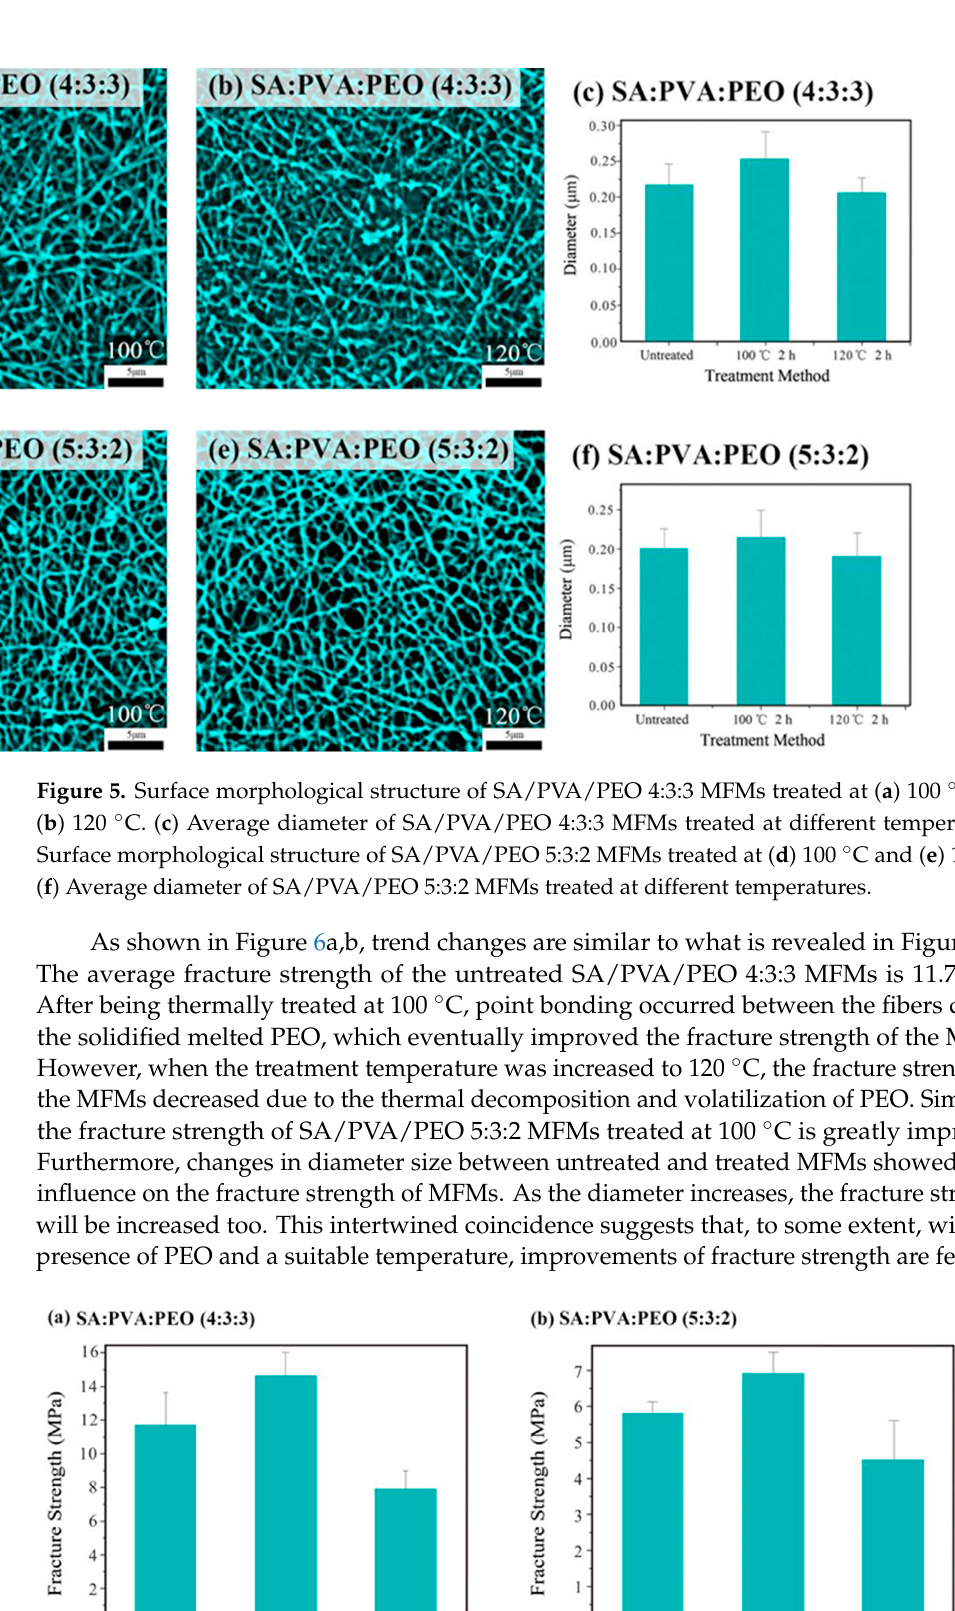
Figure 6. ( a ) Fracture strength of SA/PVA/PEO 4:3:3 MFMs treated at different temperatures ( b ) Fracture strength of SA/PVA/PEO 5:3:2 MFMs treated at different temperatures.